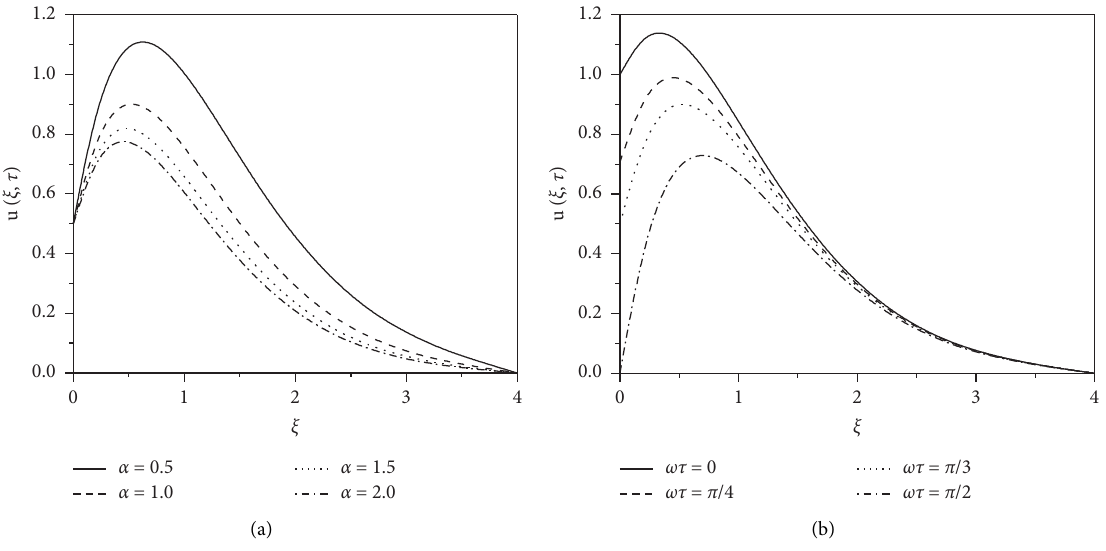
Figure 11: Variation of velocity u ( ξ , τ ) against ξ for various values of (a) α and (b) w τ